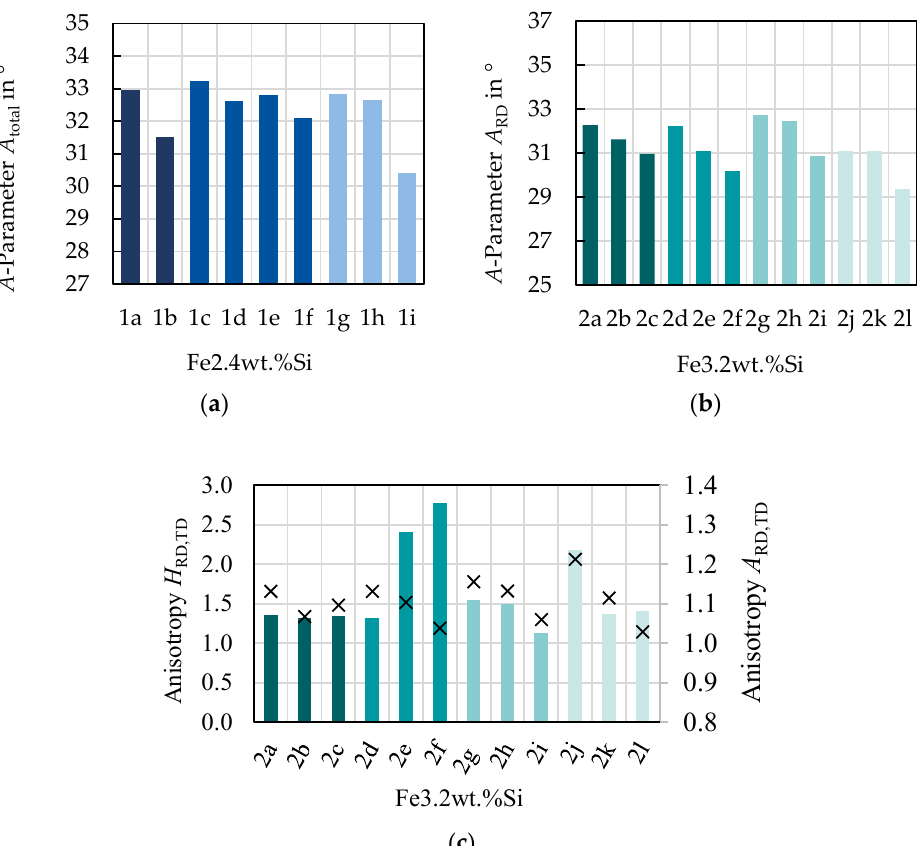
Figure 7. Evaluation of the A -parameter and magnetization behavior: ( a ) mean A -parameter for Fe–2.4 wt % Si; ( b ) mean A -parameter for Fe–3.2 wt % Si; ( c ) magnetic field at 1.0 T, 50 Hz with bars representing maximum magnetic field strength and × symbols representing A -parameters.